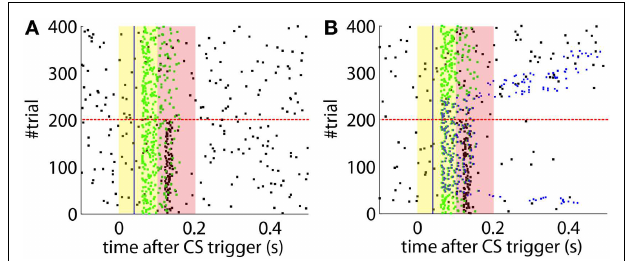
FIGURE 8 | Effect of the delayed plasticity trace on the behavior. (A) Model with plasticity trace starting (cid:51) noi seconds after each PN